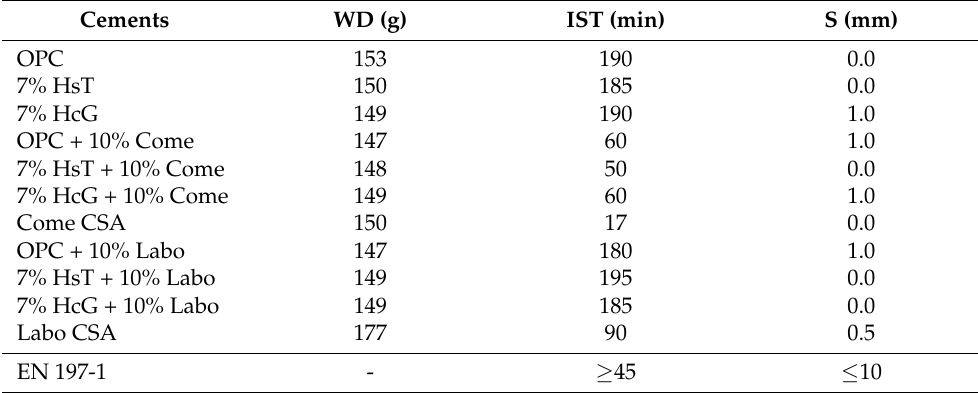
Table 5. Water Demand (WD ± 1 g), Initial Setting Time (IST ± 10 min), and Soundness (S) of the cement